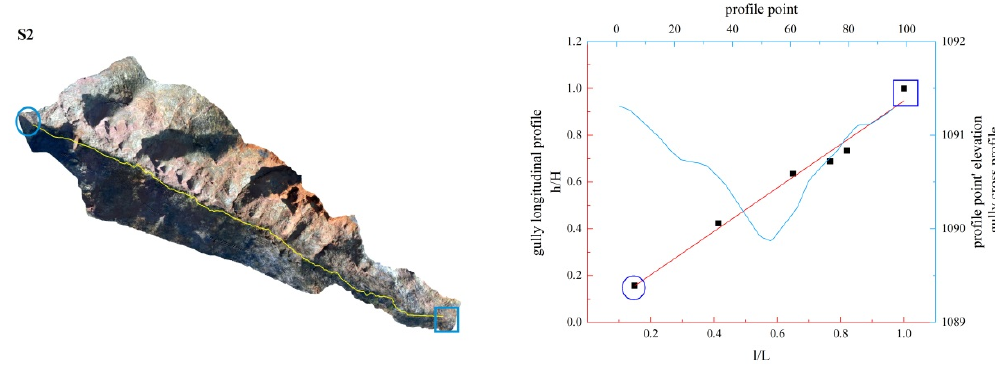
Figure 15. Gully shape and profile fitting diagram of S6.